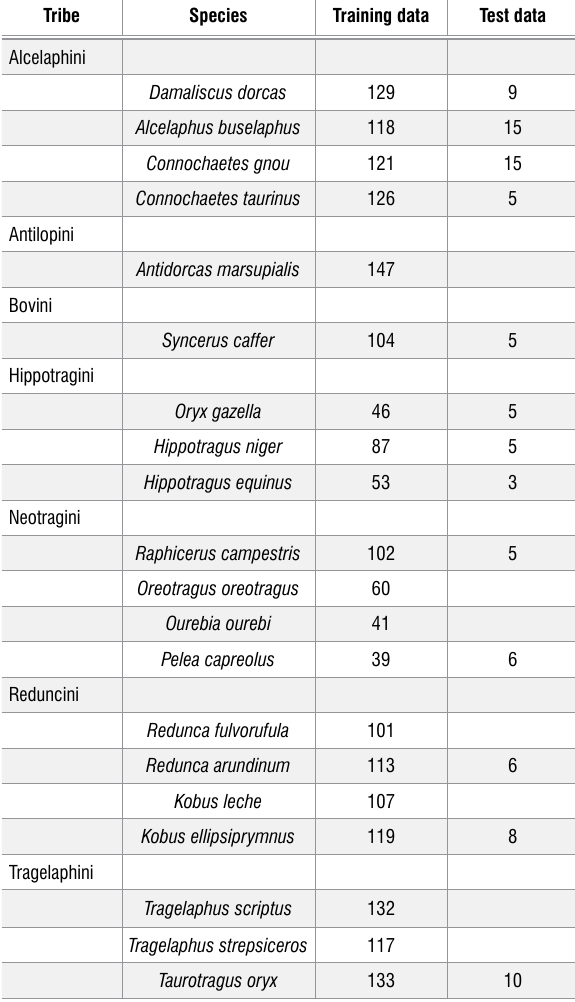
Table 1: Taxonomic list of the teeth used in the training and test data sets Tribe